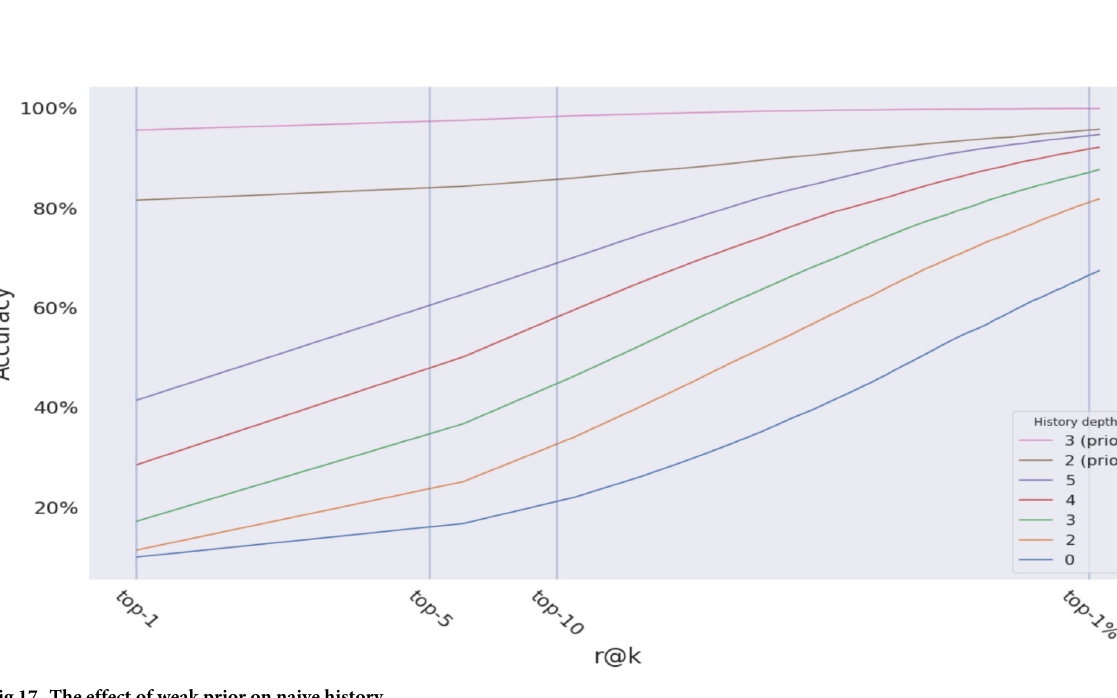
PLOS ONE | https://doi.org/10.1371/journal.pone.0283672 March 30, 2023 19 /